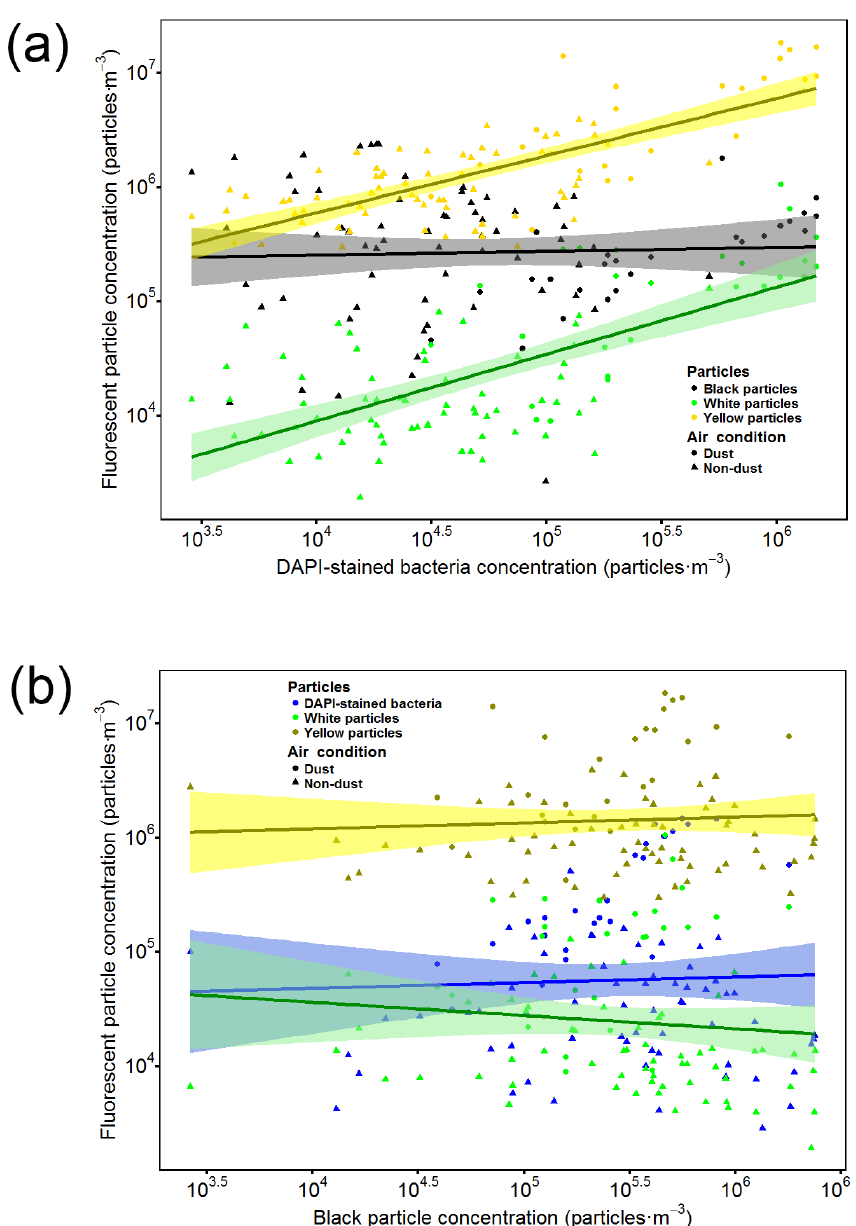
Figure 9. Changes in the concentrations of the other three kinds of fluorescent particles with the concentrations of DAPI-stained bacteria (a) and the concentrations of black particles (b) in the dust and non-dust